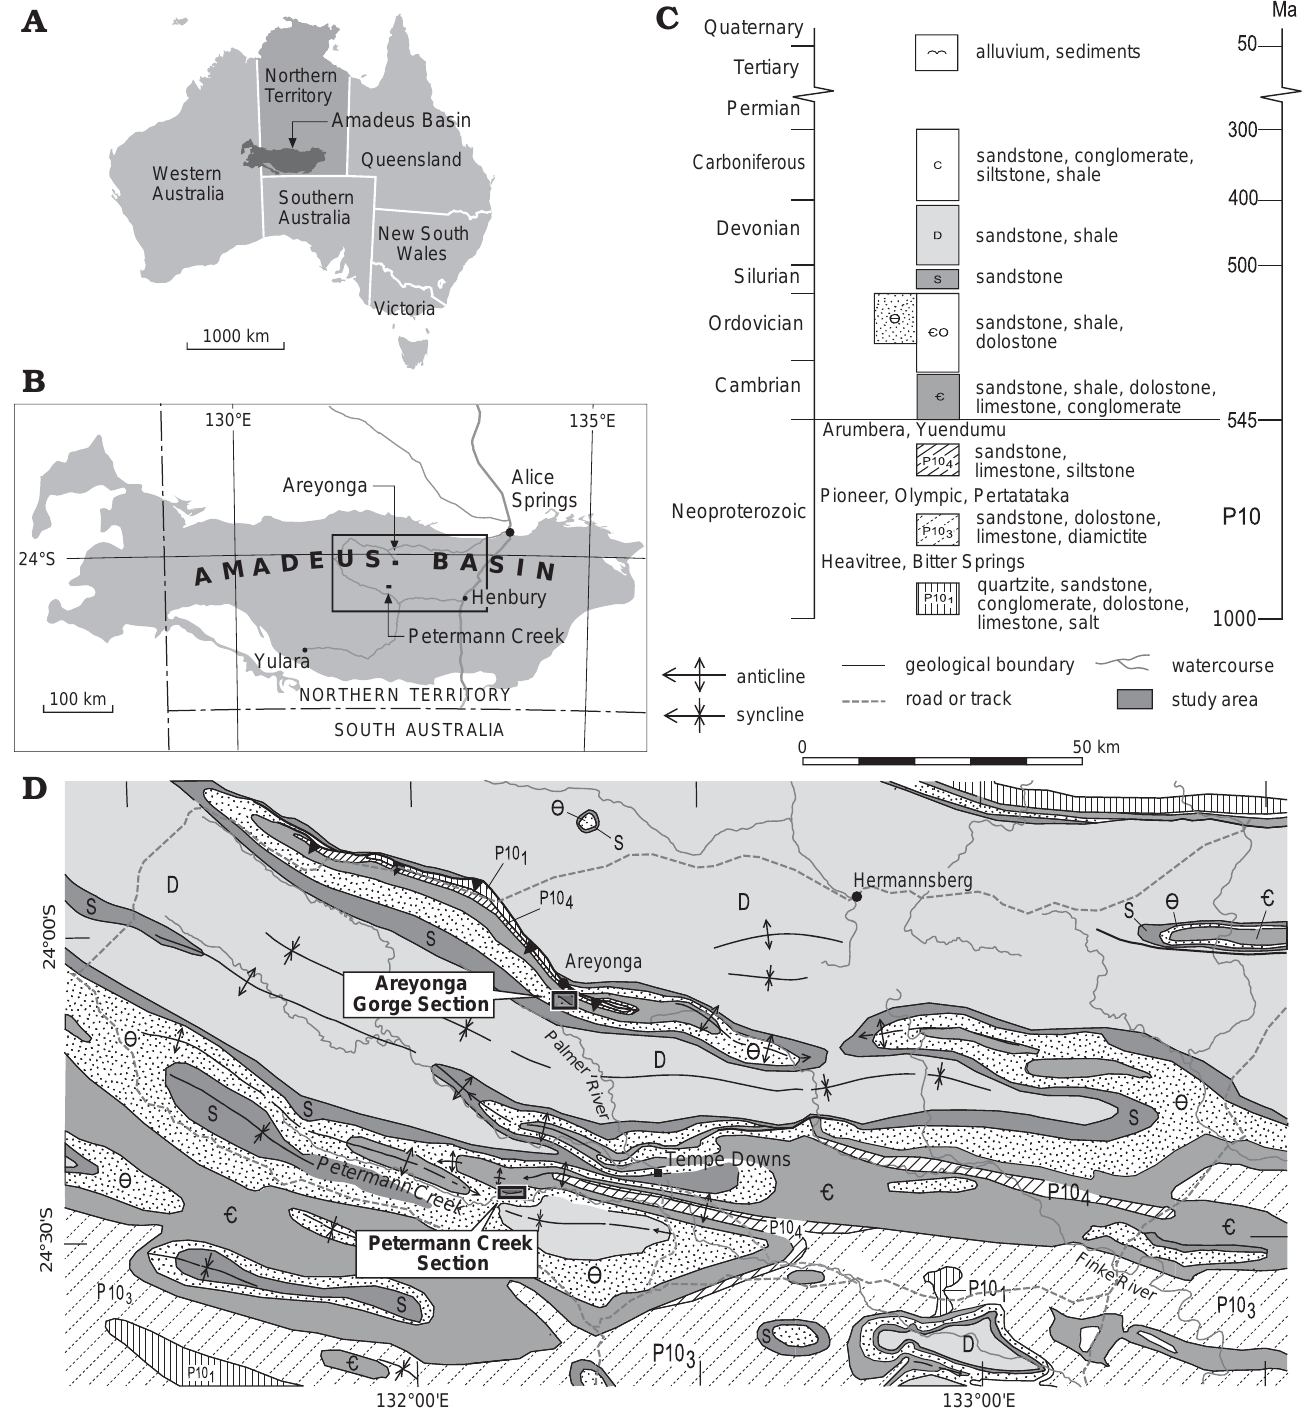
Fig. 1. Location of the Amadeus Basin within Australia ( A ). Location of the studied area within the Amadeus Basin ( B ). Generalized stratigraphy of the sedimentary deposits in the Amadeus Basin ( C ). Geological map of the two localities ( D ), also showing location of the investigated sections. Maps mod- ified after the Henbury SG5301 geological map 1:250 000. Geology base map modified from NT Geological Survey